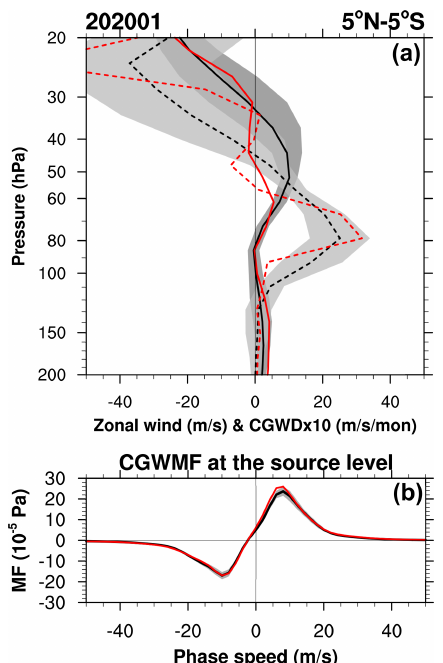
Figure 12. (a) Vertical profiles of the zonal-mean zonal wind (red solid) and zonal mean CGWD (red dashed) averaged for 5 ◦ N–5 ◦ S in January 2020 and those for the climatology (black solid and black dashed, respectively) with ± 1SD (dark-gray and light-gray shad- ing, respectively). (b) The zonal-mean zonal CGW momentum flux spectrum at the cloud top averaged for 5 ◦ N–5 ◦ S in January 2020 (red) and its climatology (black) with ± 1SD (gray